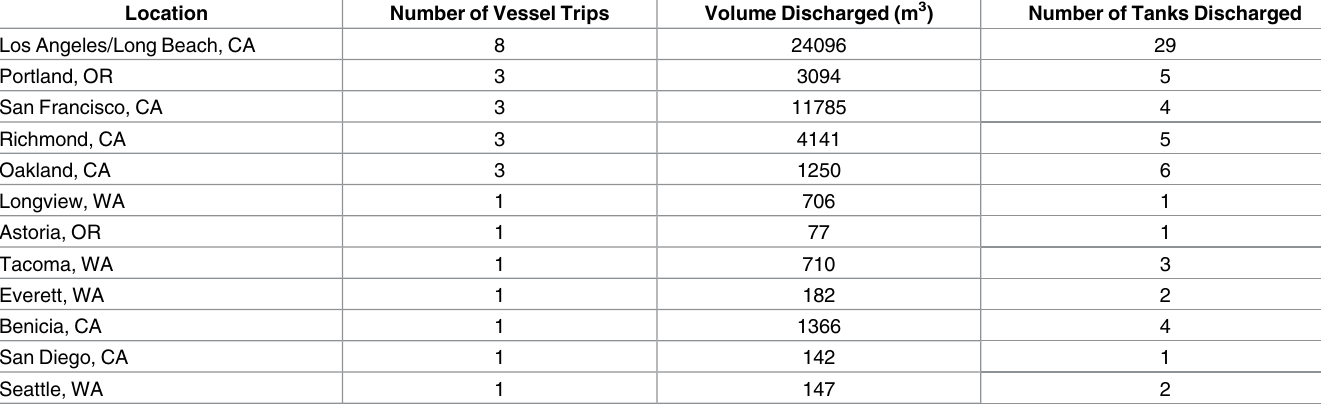
Table 1. Ports in the western USA (exclusive of Hawaii) that receiveddischarges of untreated ballast water that was sourced from the western Atlantic Ocean, Caribbean Sea or Gulf of Mexico where lionfish are known to occur. Location